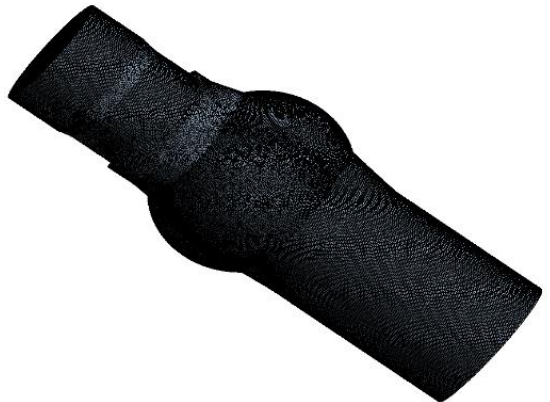
Figure 8. Computational mesh.